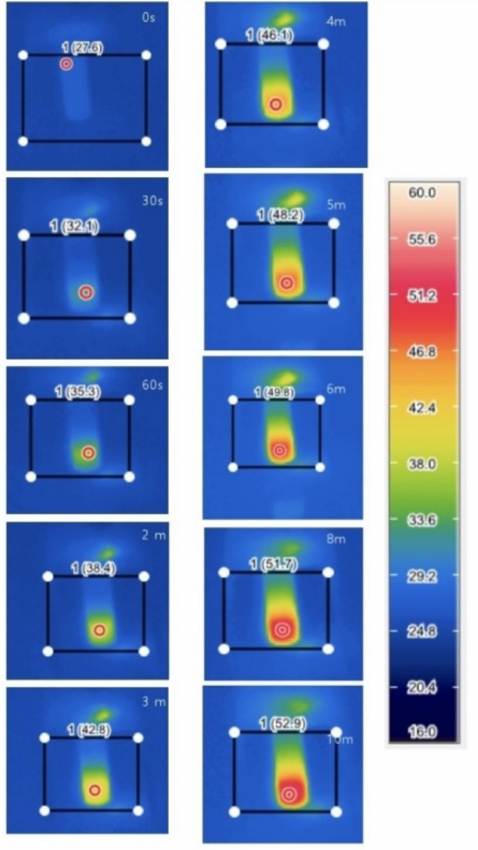
Figure 9. Infrared thermal images of the MXene − TK − DOX@PDA nanoparticles at a concentra- tion of 1 mg/mL under laser (2 W/cm 2 at 808 nm) illumination for 0, 30, 60 s, 2, 3, 4, 6, 8, and 10 min,